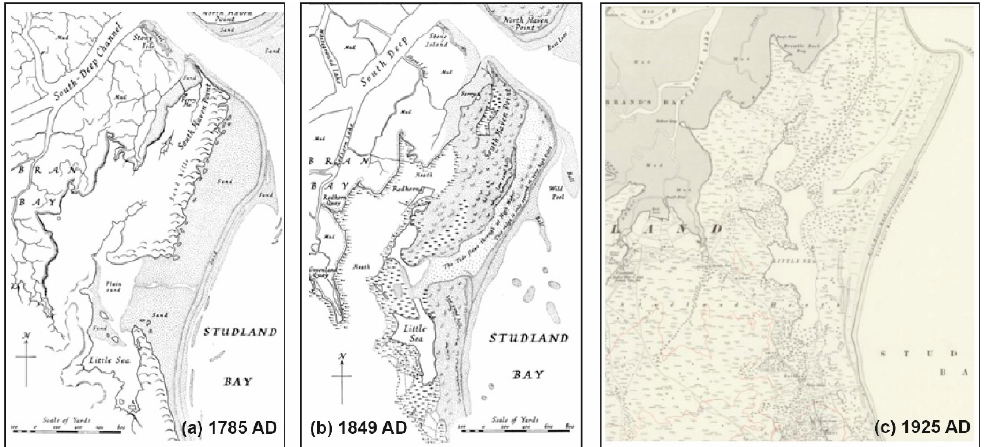
Figure 3. Physiological maps of the South Haven Peninsula during ( a ) the late 18th century AD [25]; ( b ) the mid-19th century AD [26], retrieved from Diver [6]; and ( c ) the early 20th century AD (1925 AD), retrieved from [27].